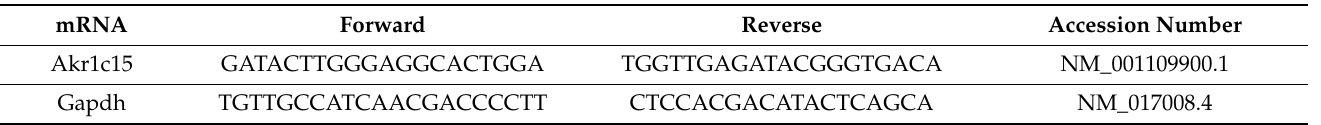
Table 2. Primers used in the